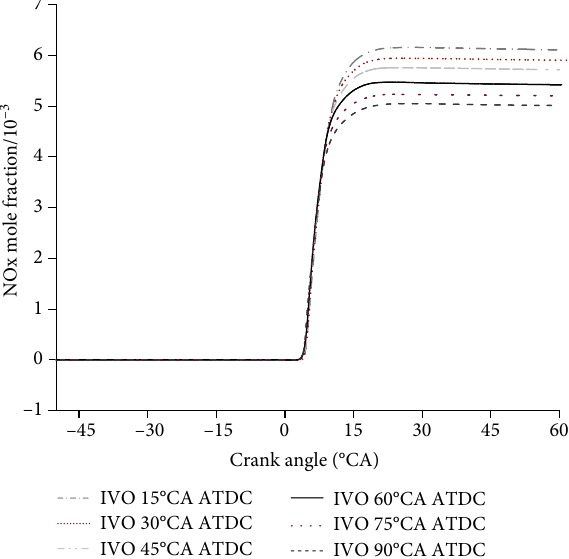
Figure 16: In fl uence of delayed IVO on pressure rise rate.